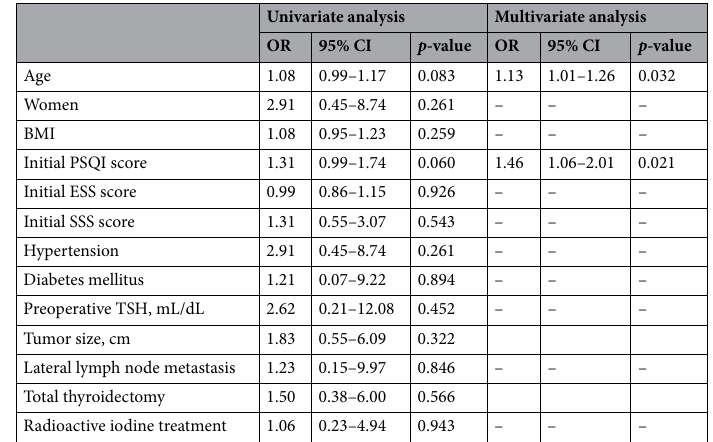
Table 5. Risk factors for persistent poor sleep quality after thyroid surgery. Persistent poor sleeper was defined as a patient who had a PSQI score greater than 7 at postoperative 10 months. OR odds ratio, CI confidence interval, BMI body mass index, PSQI Pittsburgh sleep quality index, ESS Epworth sleepiness scale, SSS Stanford sleepiness scale, TSH thyroid stimulating